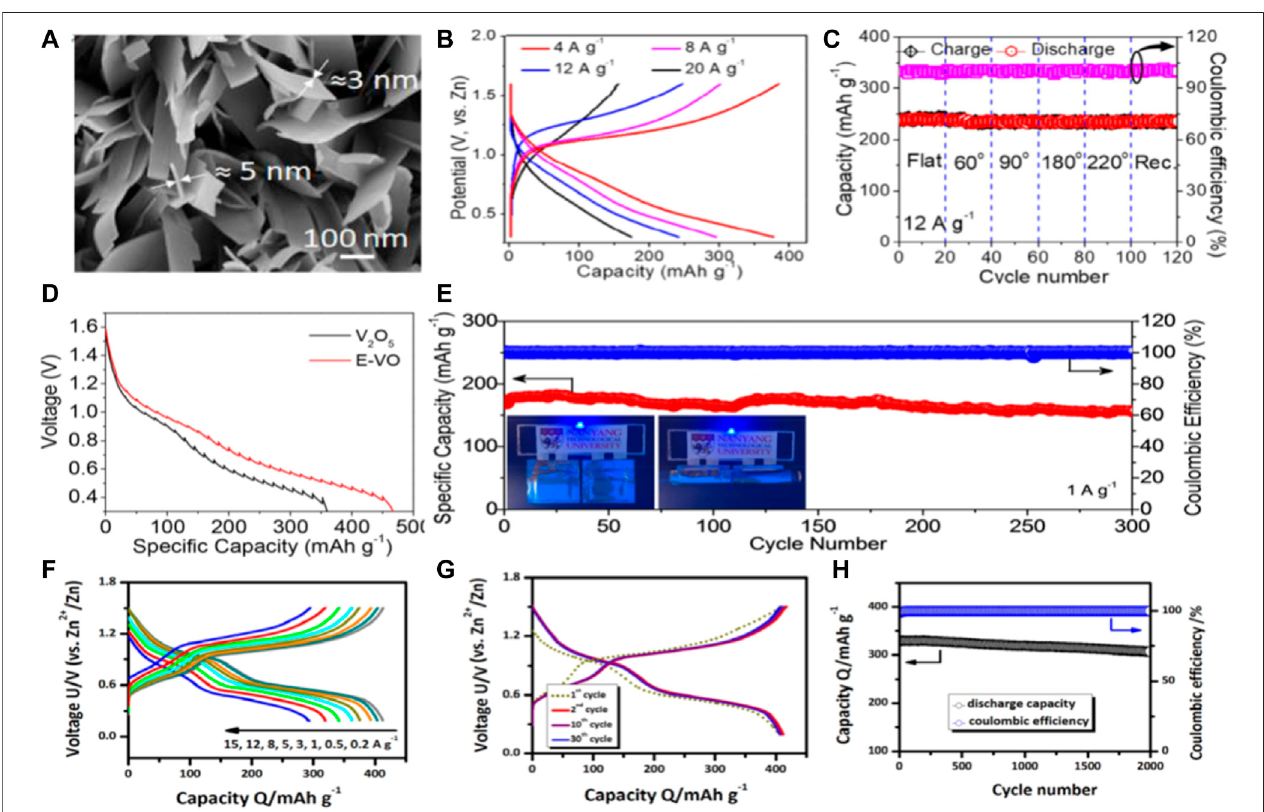
FIGURE 6| (A) High power FESEM images of V 2 O 5 nanosheets grown directly on titanium substrates, (B) Charge-discharge curvesof at various current densities in potential window of 0.3 – 1.6 V, (C) Charge-discharge pro fi les during different bending states at constant current density of 12 A/g. Copyright 2020 Elsevier Ltd. (D) Discharge GITT curves at a current density of 0.05 A/g, (E) Cycling stability and Coulombic ef fi ciency at 1 A/g. Inset in (E) shows the blue LED light up by two fl at or bending state fl exible quasi-solid-state Zn/E-VO batteries. Copyright 2019 NANOEN 3724. (F) Charge/discharge curves of the DVOC sample at different current densities. (G) Charge/discharge curves of the DVOC sample during the initial thirty cycles. (H) High-rate long-term cycling properties of the DVOC sample at 10 A/g. Copyright 2020